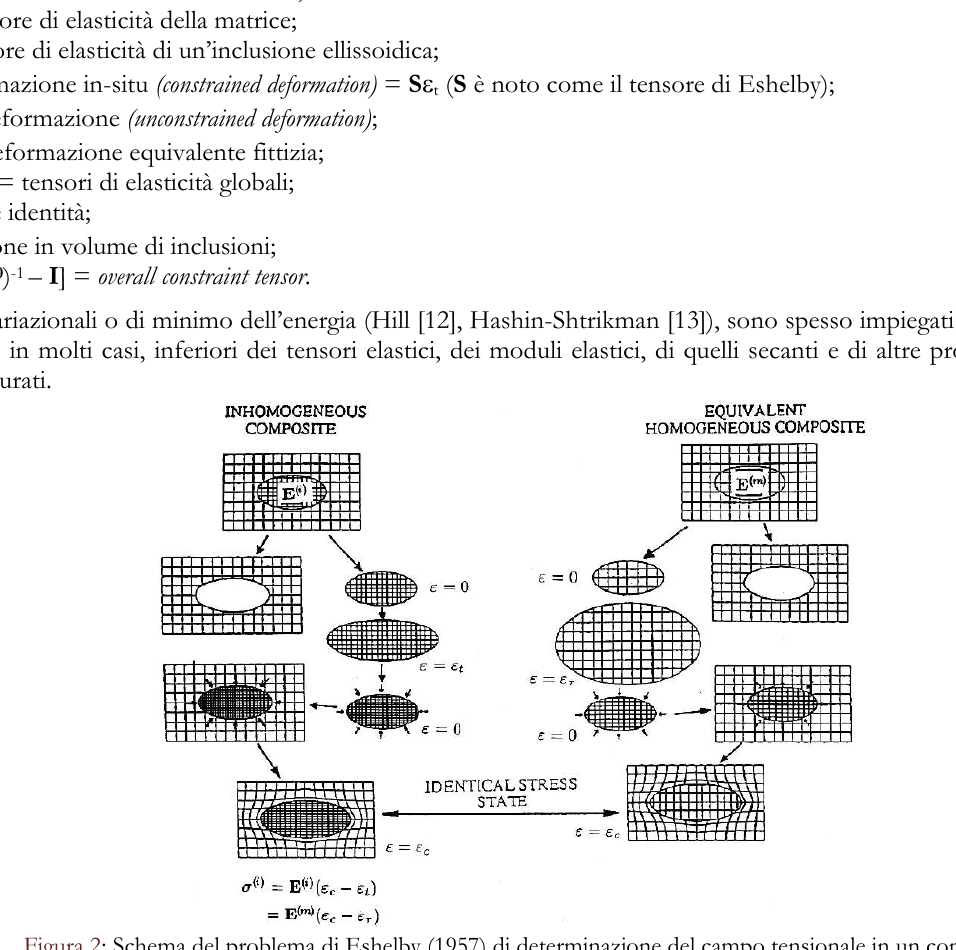
Figura 2: Schema del problema di Eshelby (1957) di determinazione del campo tensionale in un continuo elastico contenente un’inclusione soggetta alla autodeformazione  t . Immagine tratta da